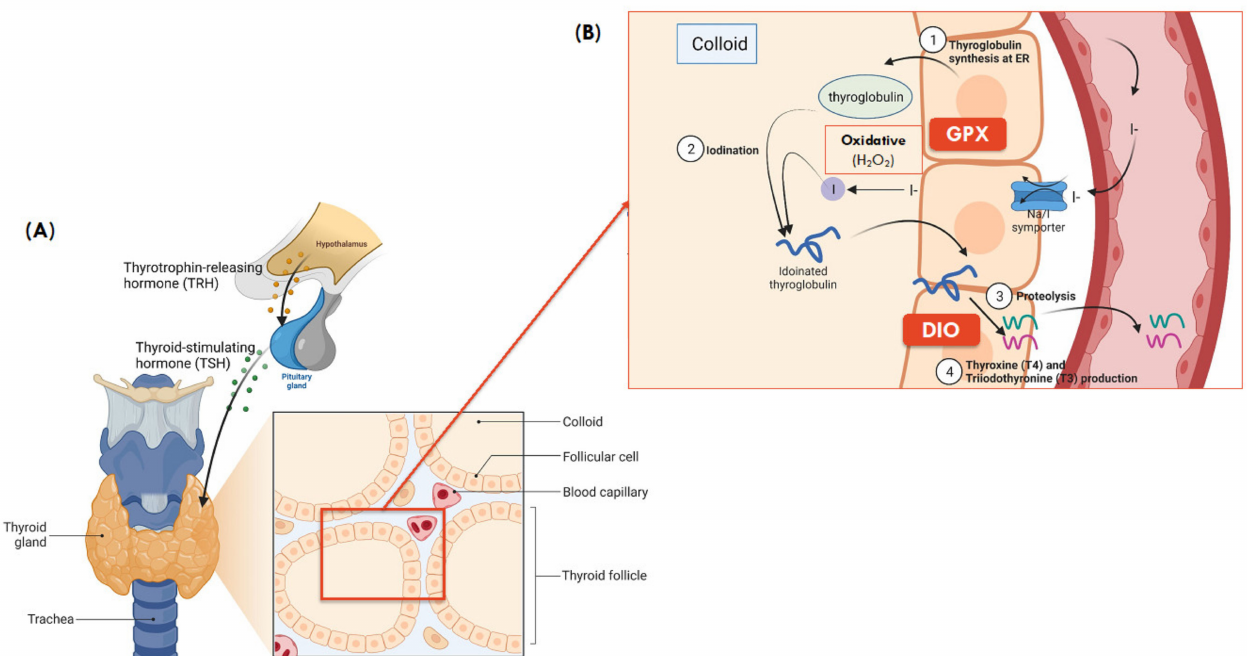
Figure 2. ( A ) Gross and microanatomy of thyroid gland. ( B ) Synthesis of thyroid hormones and role of selenoproteins in colloid of thyroid ( Adapted from “Thyroid Gland Anatomy and Histology”, by BioRender.com (2021). Retrieved from https://app.biorender.com/biorender-templates, accessed on 13 April 2021) and is adapted from [71]. ( 1 ) Thyroglobulin synthesis: thyroglobulin, the building block of thyroid hormone is synthesized in the endoplasmic reticulum of follicular cells; ( 2 ) Iodination: iodine then combines with thyroglobulin, forming iodinated thyroglobulin after a series of iodination processes; ( 3 ) Proteolysis: the iodinated thyroglobulin is broken down into T4 (~90%) and T3 (~10%) hormones; ( 4 ) T3 and T4 production: Both T3 and T4 then travel in blood and reach different tissues, where T4 is further broken down to the active T3 in local tissues, primarily in the liver to regulate fat and carbohydrate metabolism, thermogenesis, growth, and development